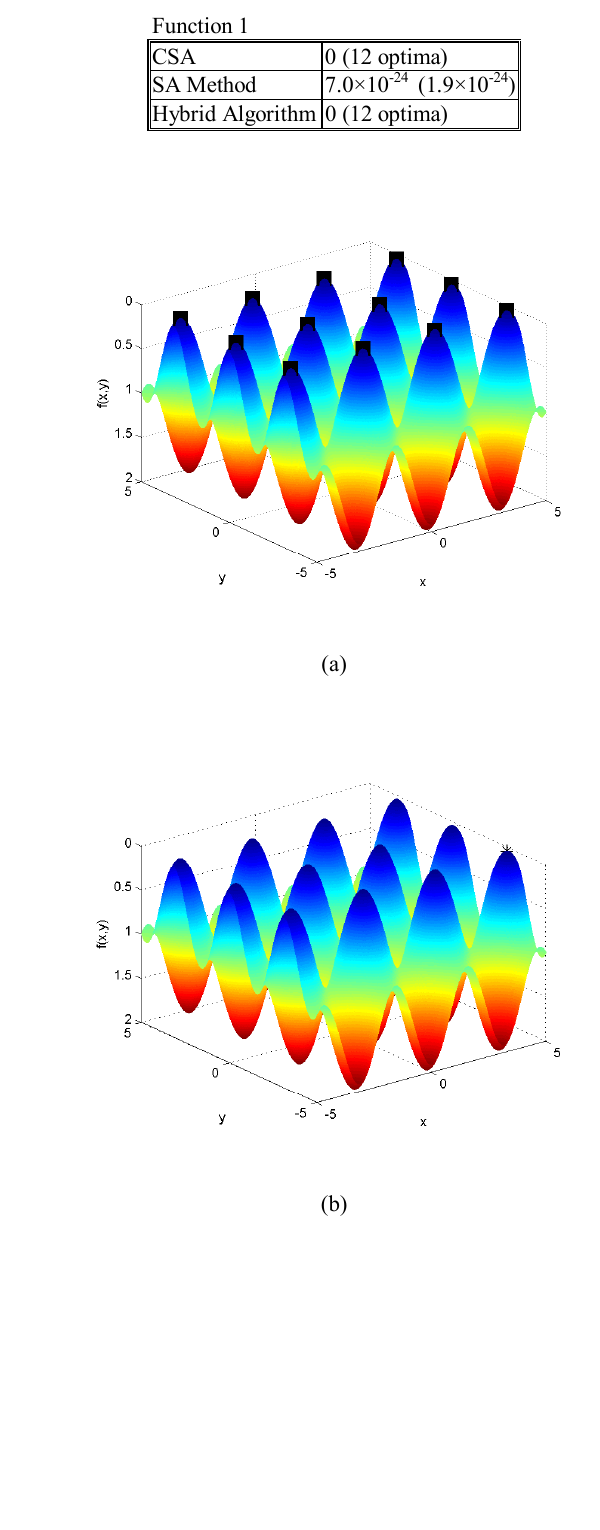
Table 3. Performance comparisons of three optimization methods in Function 1 (optima ± standard